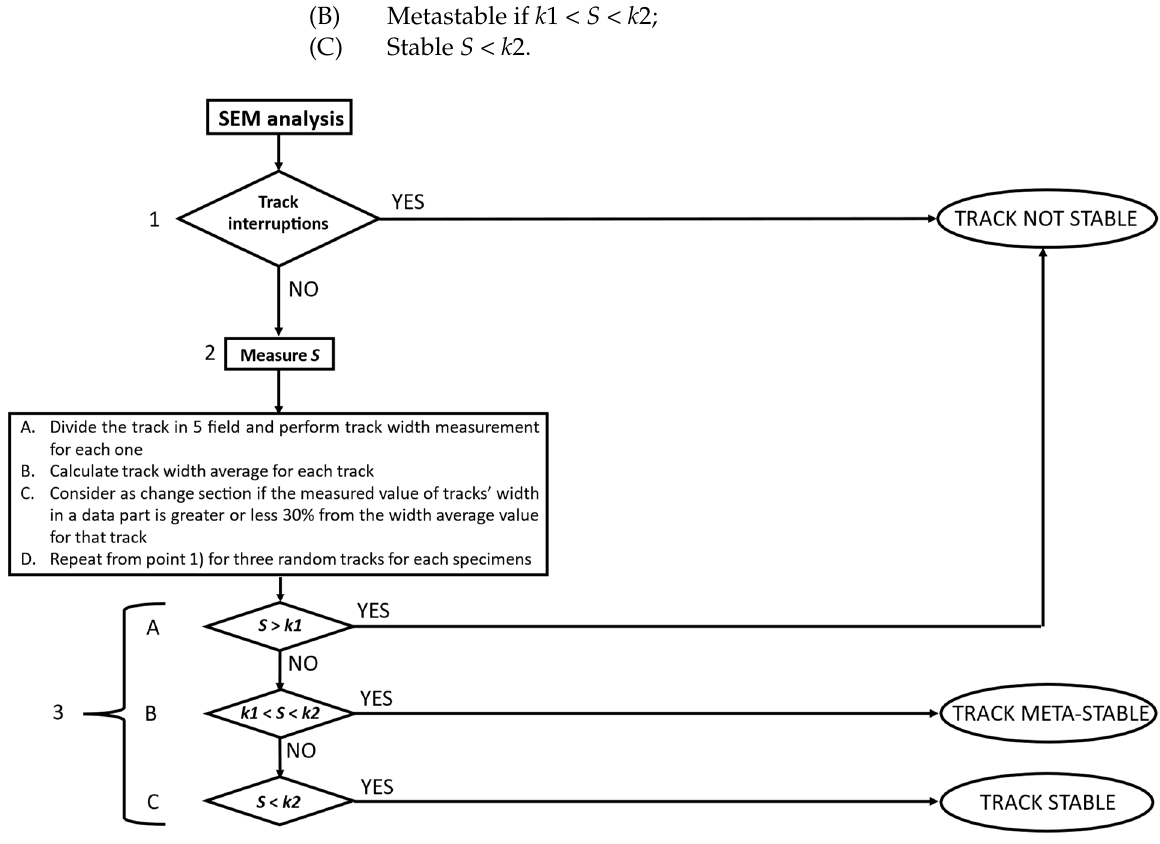
Figure 4. Flowchart of track stability evaluation method.